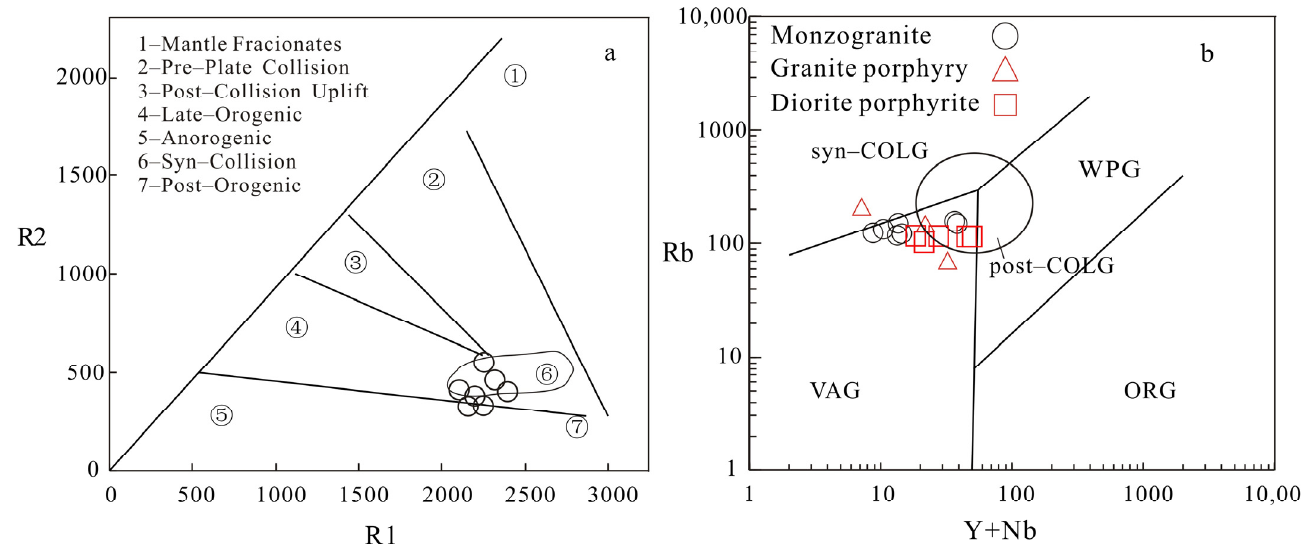
Figure 13. R1–R2 ( a ) and Rb–(Y + Nb) ( b ) diagrams for the Tianzishan monzogranite, granite porphyry and diorite porhpyrite dike samples.